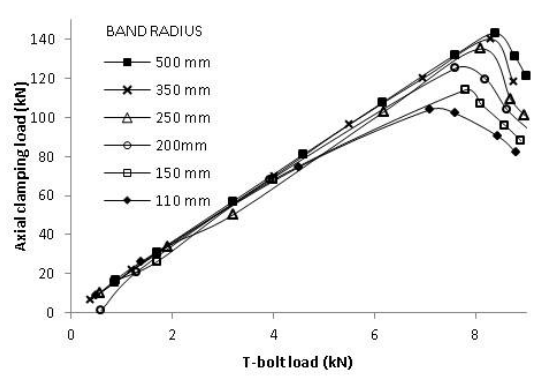
Figure 10: Axial clamping load against T-bolt load (variable V-band radius).